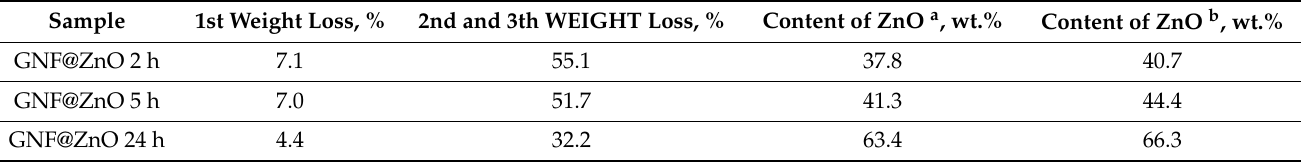
Table 2. The thermal analysis